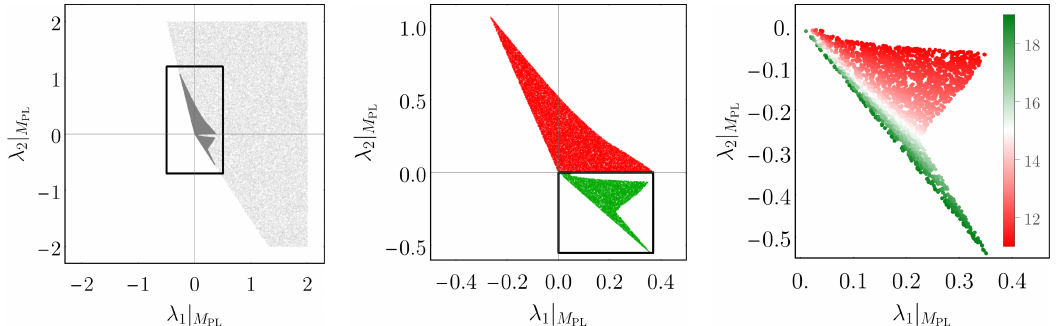
Figure 1 . Successive constraints arising from an admissible scalar potential, cf. section 2, on the Planck-scale theory space of quartic couplings in an SO(10) GUT with 45 and with g | = 0 . 425 . The left-hand panel shows allowed regions arising from (I.a) stability M Pl (light-gray region) and from (I.b) perturbativity (dark-gray region). The middle panel zooms in on the resulting stable and perturbative region and shows the additional constraint. (I.c) arising from the deepest radiative minimum occurring in a non-admissible direction (red upper region). The right-hand panel zooms in on the remaining admissible region (lower green region in the middle panel) and shows the additional constraint (II.a) from proton decay. The colour scale indicates log (M ) , with M the breaking scale. The breaking scale is constrained by proton decay, GUT GUT 10 with only the lower green stripe remaining potentially